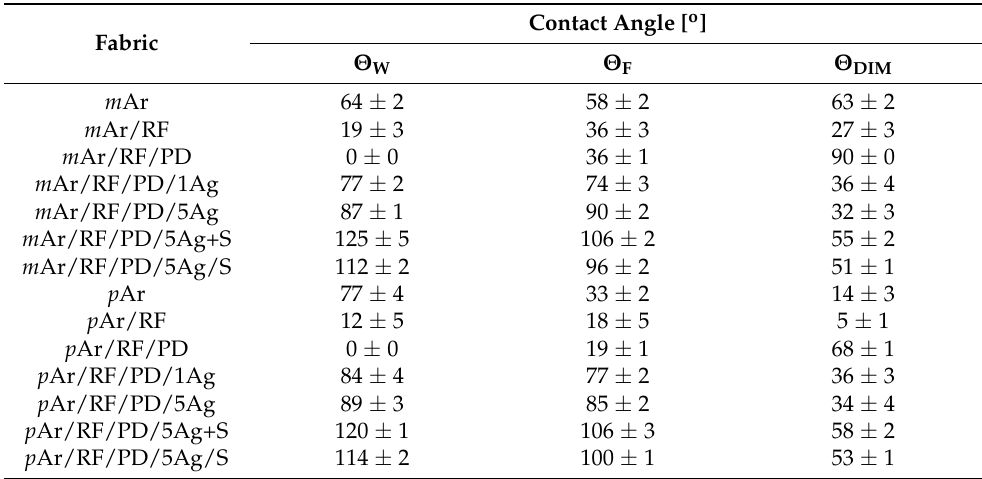
Table 5. Contact angles of water ( Θ W ), formamide ( Θ F ), and diiodomethane ( Θ DIM ) for unmodified and modified m Ar and p Ar